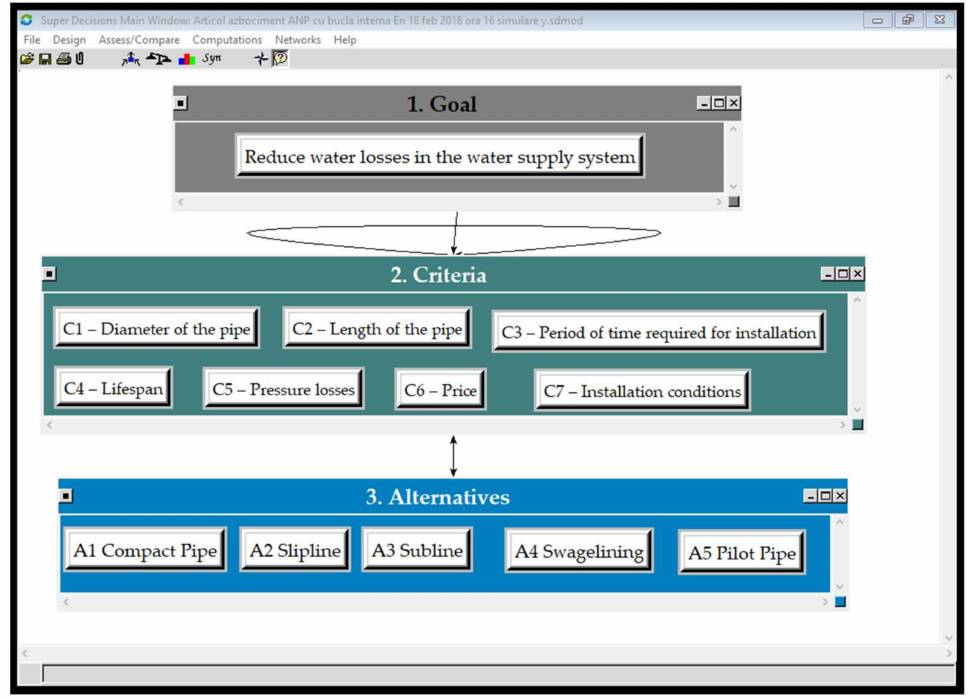
Figure 3. Ranking structure of the network analytical process for selecting the optimal alternative.